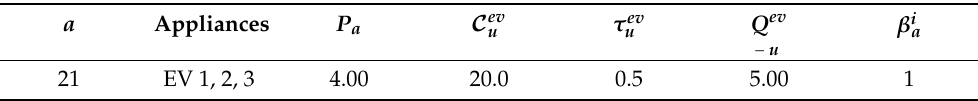
Table 3. Technical Data related to EVs ( β a = −